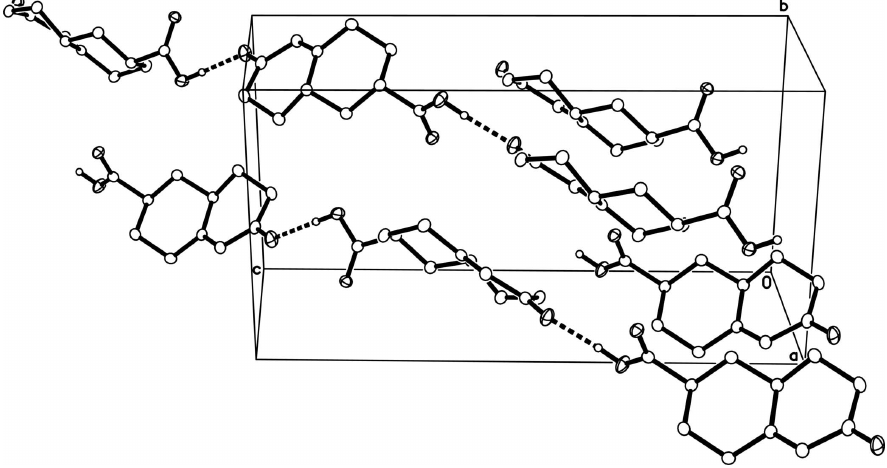
A partial packing diagram with extracellular molecules, illustrating the centrosymmetrically related pairs of acid-to- ketone H-bonding chains passing through the cell. All carbon-bound H atoms are removed for clarity. Displacement ellipsoids are drawn at the 40% probability